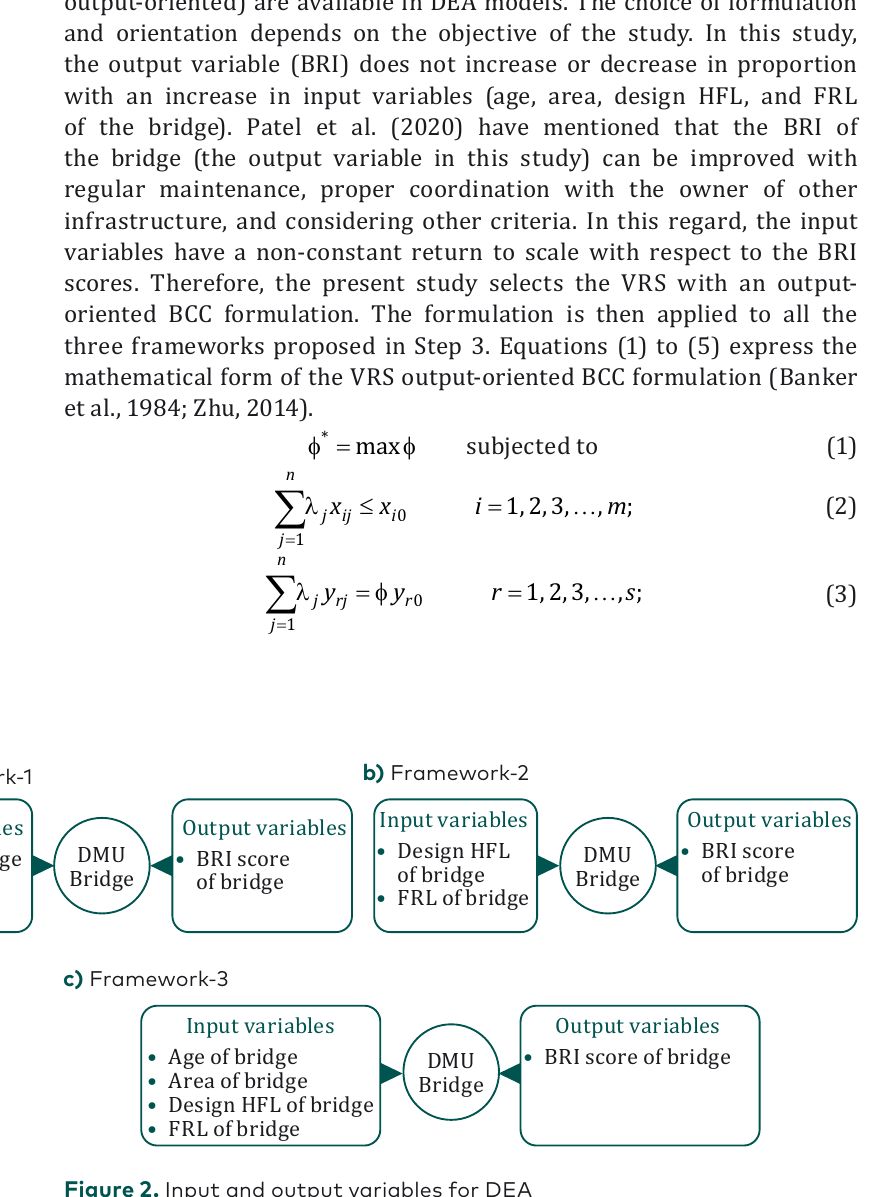
Figure 2. Input and output variables for